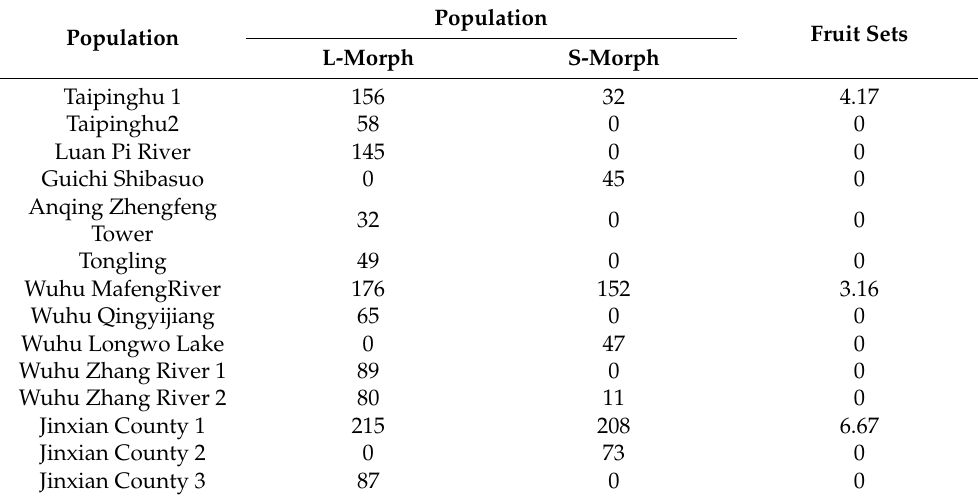
Table 5. Seed sets of P.criopolitanum in different populations under natural conditions.